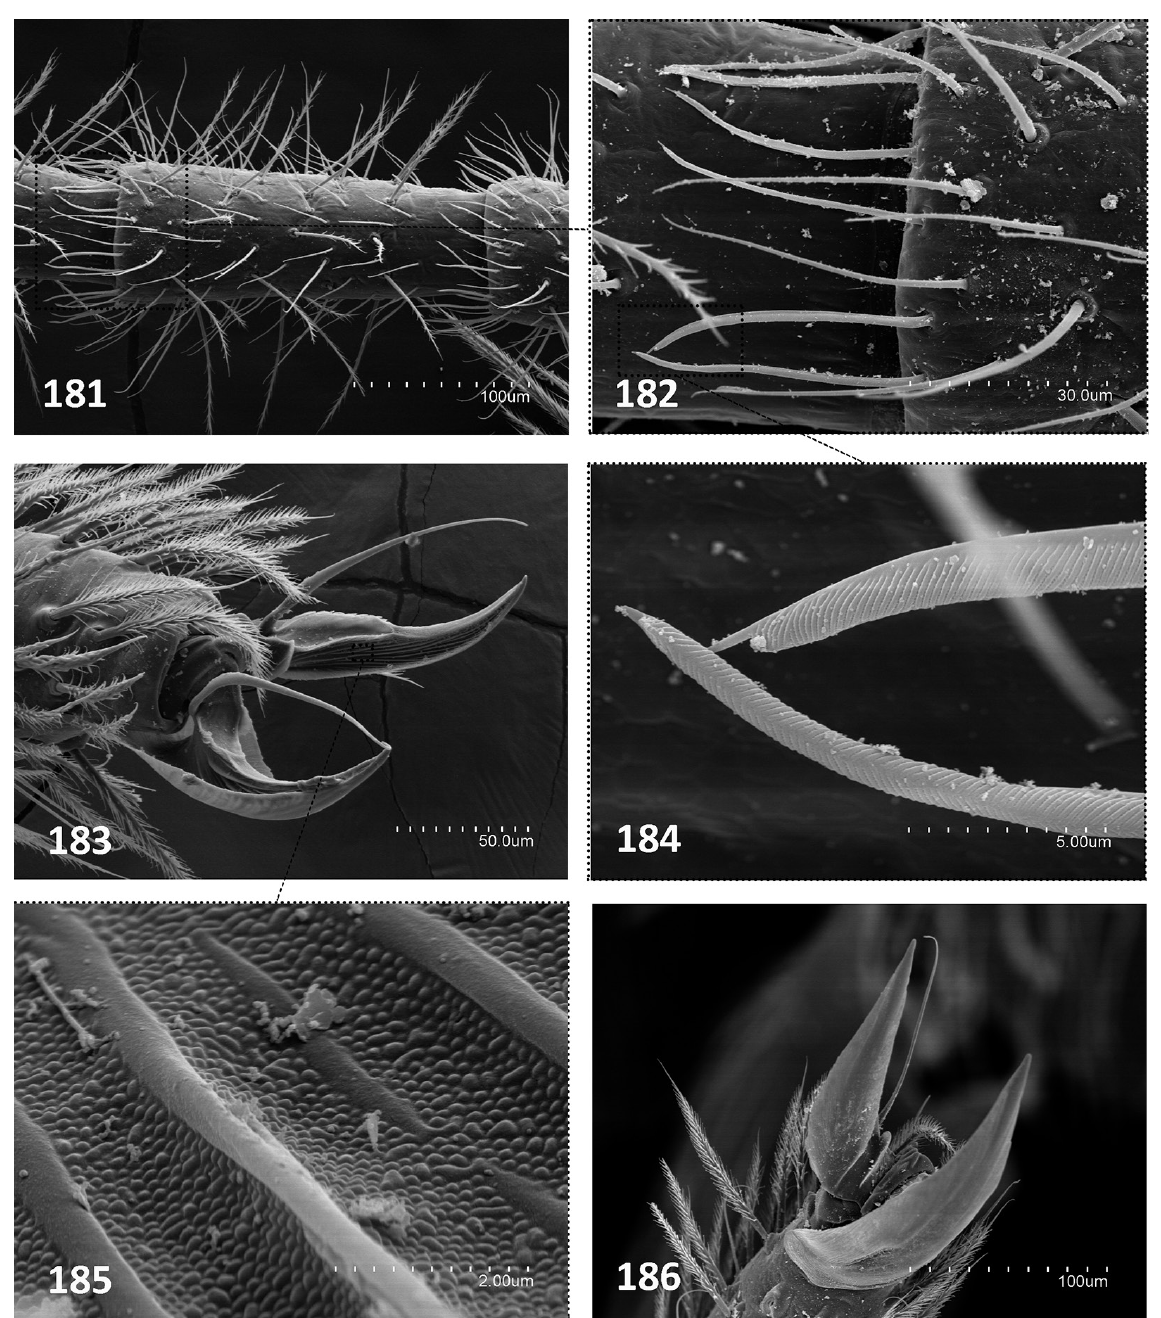
Figs 181–186. Plusiocampa ( Stygiocampa ) remyi Condé, 1947, from Njegoš pećina, Njeguši, Kotor, Montenegro (Coll. AS). 181 . Medial antennomere. 182 . Distal portion of a medial antennomere. 183 . Pretarsus of a metathoracic leg, lateral view with posterior claw in the foreground. 184 . Distal portion of two gouge sensilla. 185 . Ventral side of anterior claw, detail. 186 . Pretarsus of a metathoracic leg, dorsal